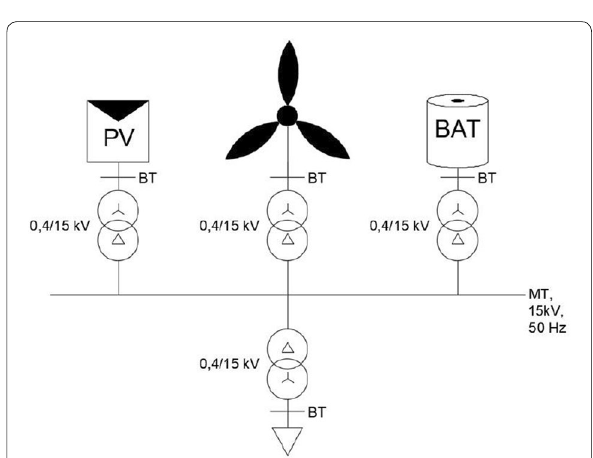
Fig. 3 General scheme of the hybrid system to be installed in the archipelago (sourced from Sónia and Artur (2018))